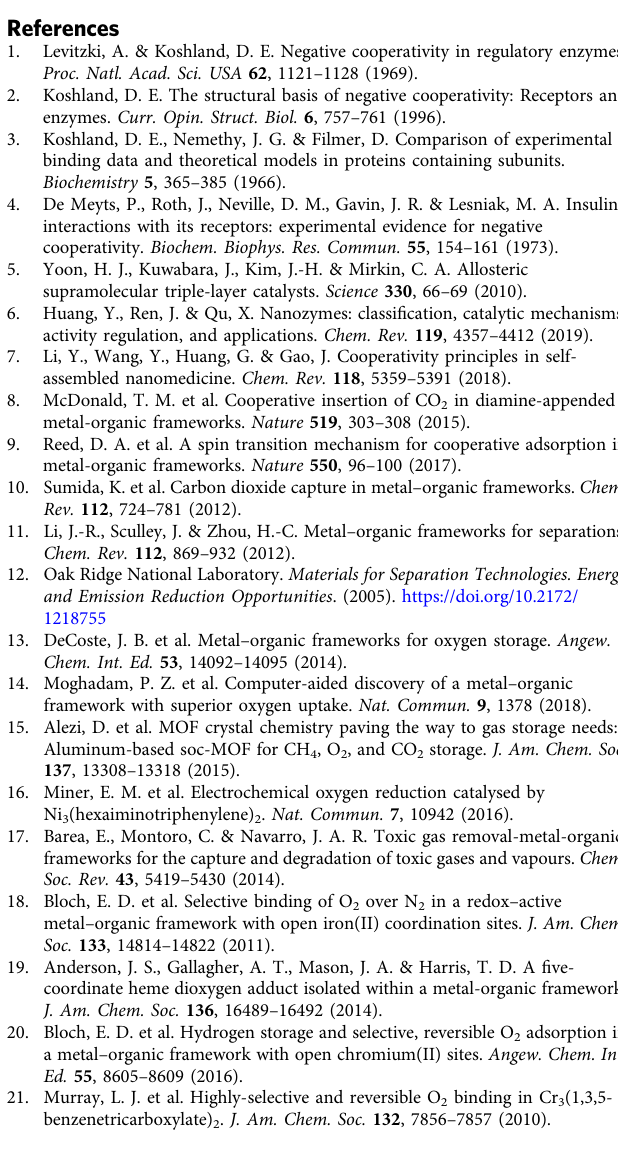
Data availability The main data supporting the fi ndings of this study are available within the paper and its Supplementary Information. The source data underlying Figs. 3 and 6 are provided as a Source Data fi le. Other data are available from the corresponding author upon request. Metrical data for the solid-state structures of Co 2 Cl 2 (bbta), O 2 -dosed Co 2 Cl 2 (bbta), Co 2 (OH) 2 (bbta) and O 2 -dosed Co 2 (OH) 2 (bbta) are available free of charge from the Cambridge Crystallographic Data Centre under reference numbers 1965641 –